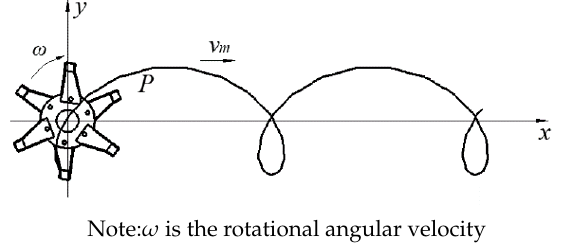
Fig. 6. Fixed cutter